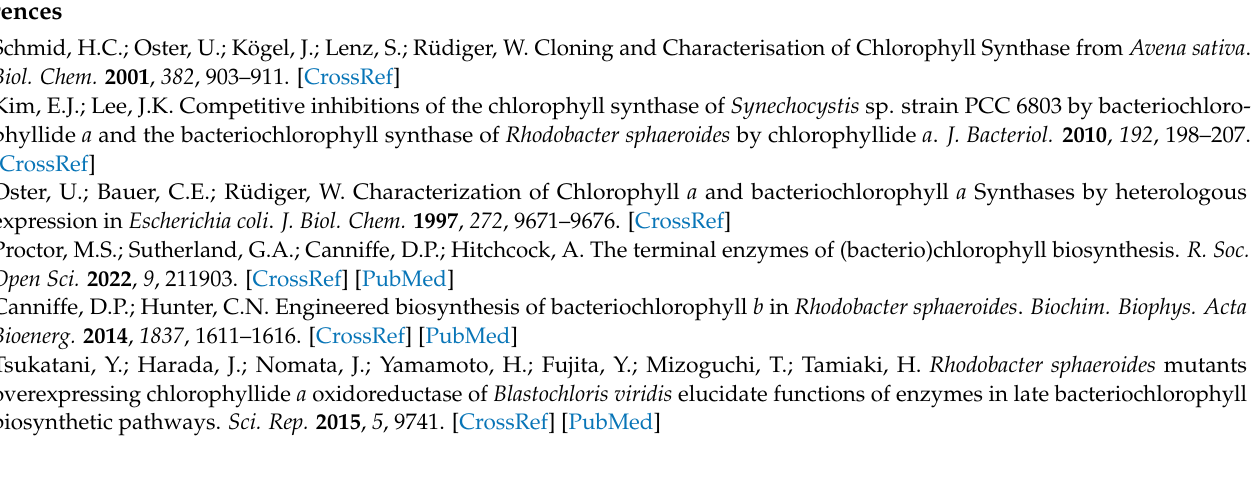
Table S3: Plasmids; Table S4: Kinetic parameters of NtChlG2; Figure S1: Quantification of BchG and ChlG in E. coli lysate; Figure S2: ChlG and BchG activities in leaf lysates of N. tabacum ; Table S5: K m of native ChlG from leaf lysates of N. tabacum for BChlide a and Chlide a ; Figure S3: Inhibition plots of RsBchG and SyChlG for chlorin and bacteriochlorin, respectively; Figure S4: Detection of free Chl a P in the membranes of BG1 expressing angiosperm chlG s; Figure S5: Effect of NtchlG expression on the photoheterotrophic growth of WT; Figure S6: Chl a P formation by Prochlorococcus marinus ChlG in R. sphaeroides ; Figure S7: Evolutionary analysis of BchGs and ChlGs; Amino acid sequence of BchG and ChlG; Construction of plasmids; Clear-native PAGE; Kinetic analysis of BchG and ChlG activities in leaf extract of N. tabacum . References [2,8,11,16,17,27,29,38–42] are cited in the supplementary